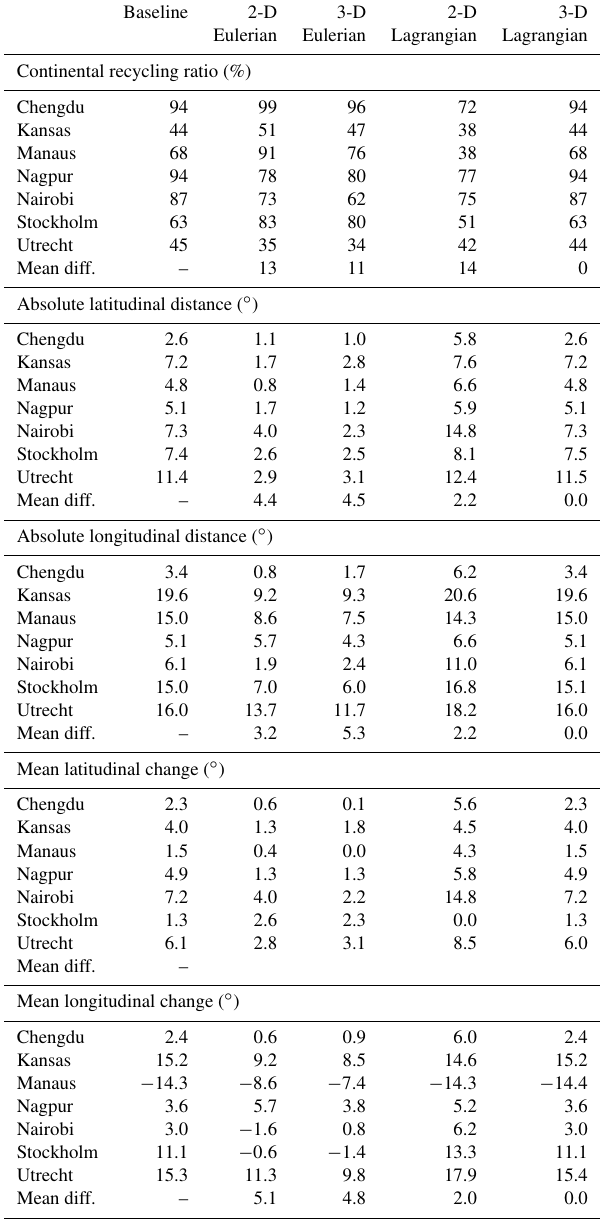
Table 1. Continental recycling ratio (%), absolute latitudinal dis- tance ( ◦ ), absolute longitudinal distance ( ◦ ), mean latitudinal change ( ◦ ), mean longitudinal change ( ◦ ), and calculation time (CPU seconds) for the baseline, two-dimensional Eulerian, three- dimensional Eulerian, two-dimensional Lagrangian, and three- dimensional Lagrangian model versions for each of the seven point sources in July 2012. For continental recycling ratio, absolute lat- itudinal distance, absolute longitudinal distance, mean latitudinal change, and mean longitudinal change, the absolute differences with the baseline model are also given. Baseline